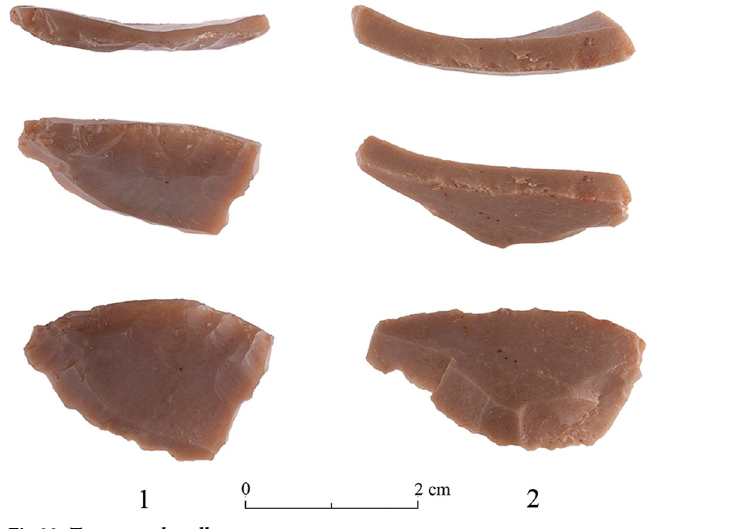
Fig 30. Transversal spalls.